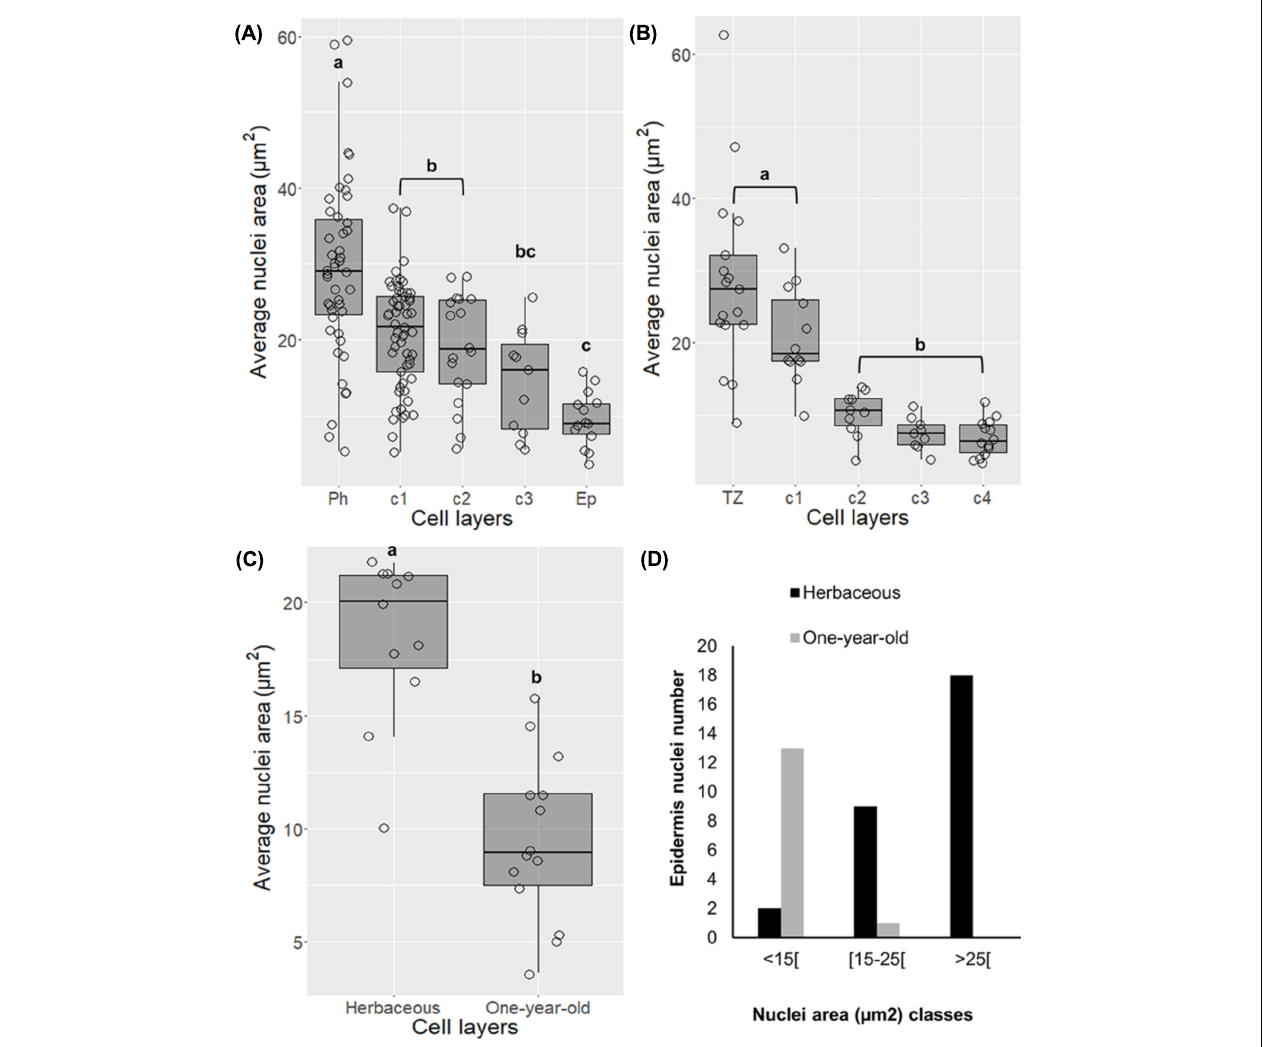
FIGURE 2 | Changes in nuclei area in differentiating cork cells in young periderms from one and three-year-old sprigs (A) , in traumatic periderms (B) , and in epidermis from herbaceous (entire epidermis) to one-year-old sprigs (disrupted epidermis) (C) . (D) Epidermis from one-year-old sprigs shows no nuclei with areas higher than 25 µ m 2 . Boxplots represent minimum nuclei area, first quartile (bottom of box), median, third quartile (top of box), and maximum. The distribution of every individual measurement is represented by jittered